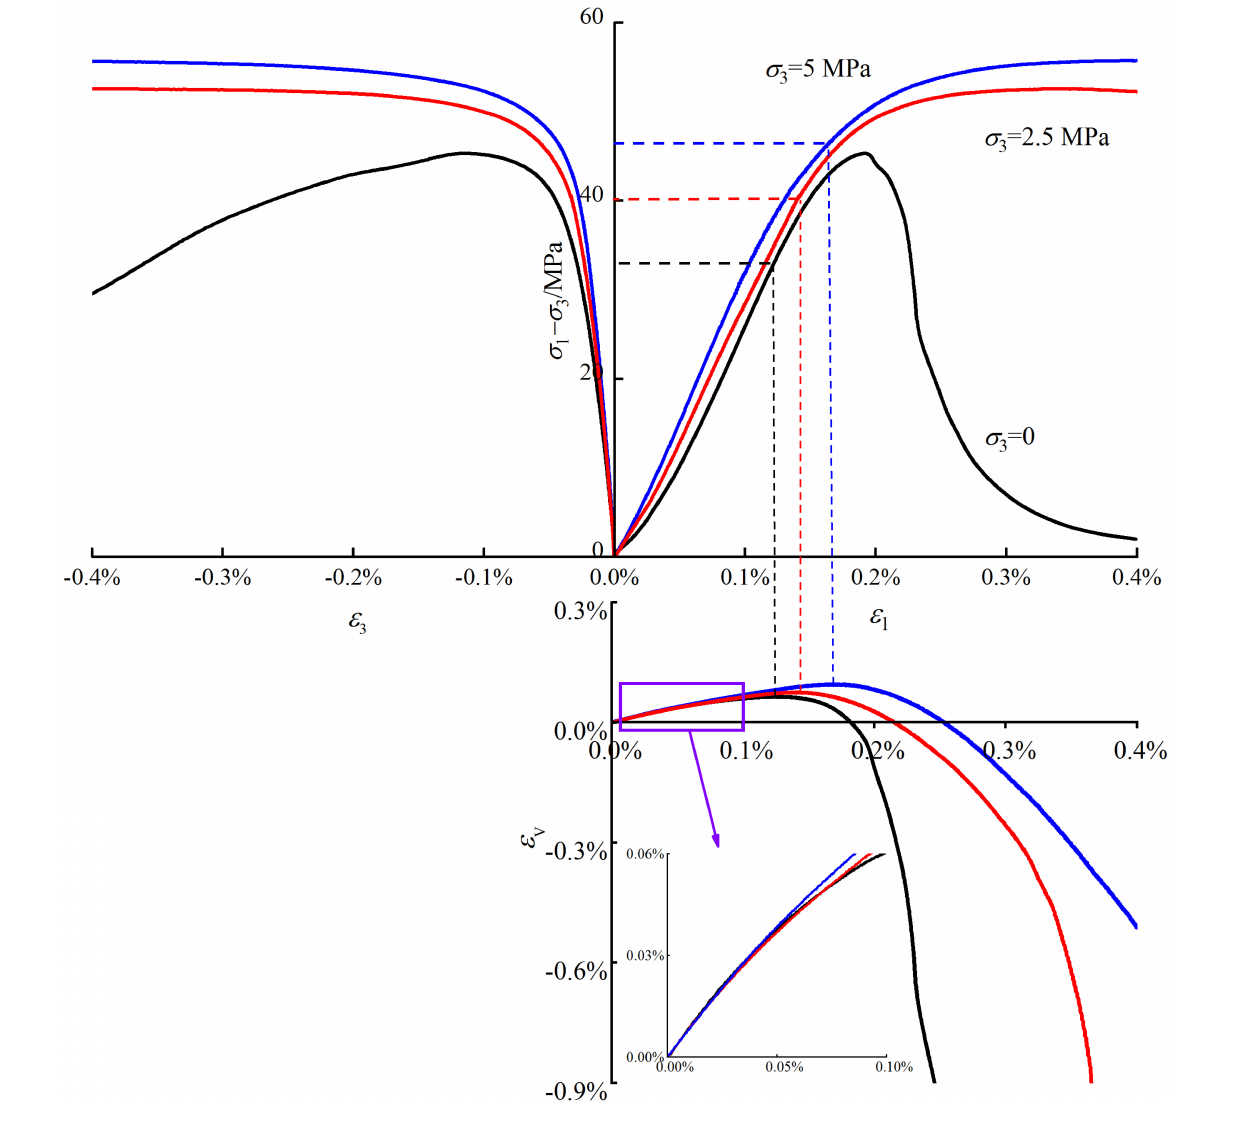
FIGURE 2 | Stress–strain curves under different confining